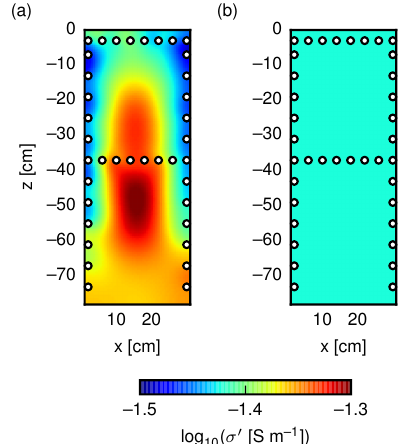
Figure 2. EIT inversion results (real component of complex con- ductivity) for measurements on a rhizotron filled with water of known conductivity (375µScm − 1 = 10 − 1 . 43 Scm − 1 ) without (a) and with (b) correction of the impedance data for the imperfect 2-D situation.